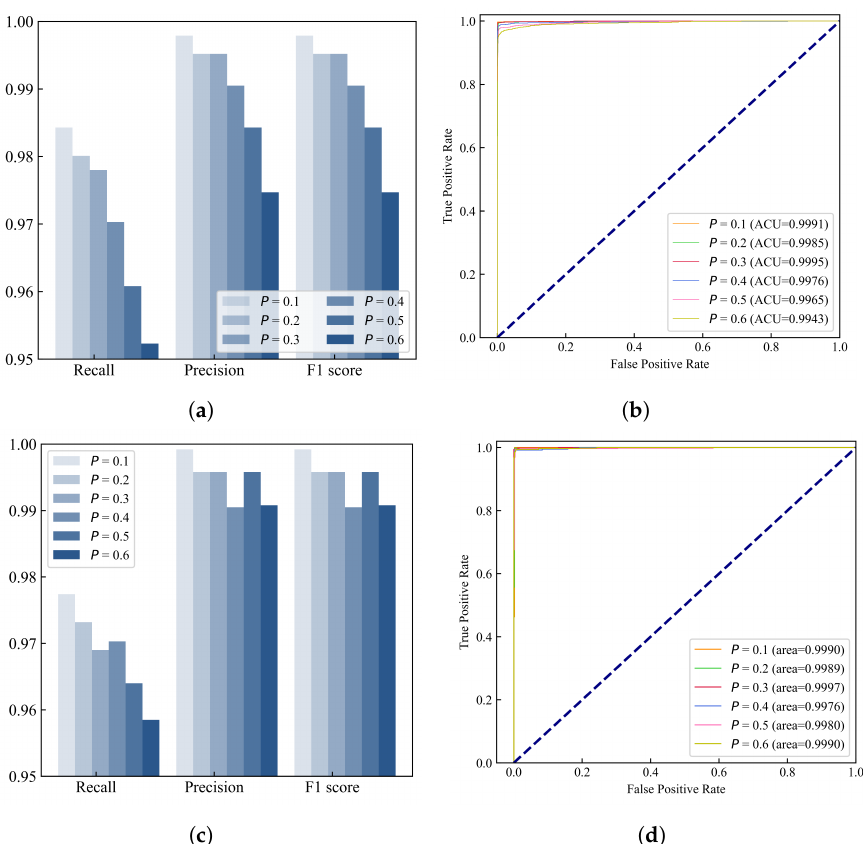
Figure 7. LPSMN performance among different removing-ratio networks on a real-world network. ( a ) Recall, precision and F1 score among different removing-ratio networks on WD; ( b ) AUC among different removing-ratio networks on WD; ( c ) Recall, precision and F1 score among different removing- ratio networks on FT; ( d ) AUC among different removing-ratio networks on FT.